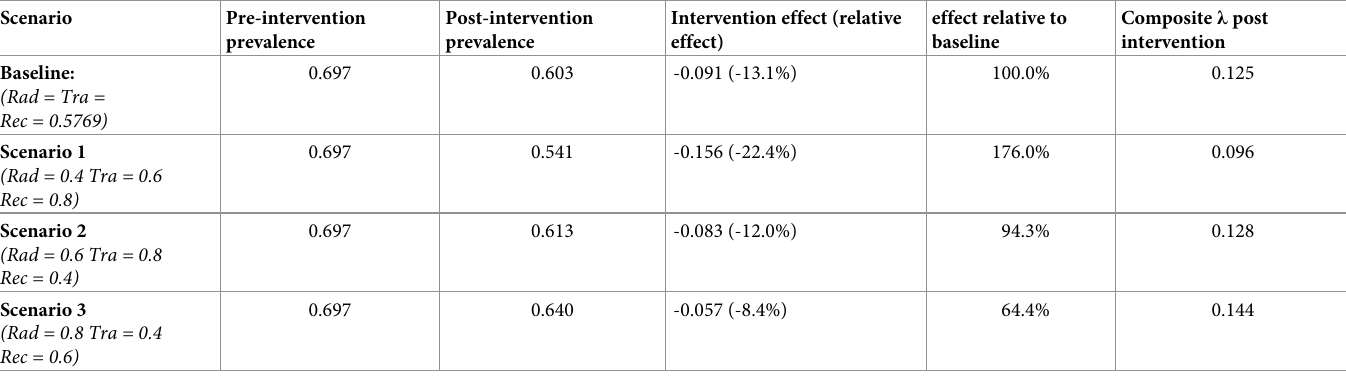
Table 3. Intervention effects for four scenarios, under random seeding on network